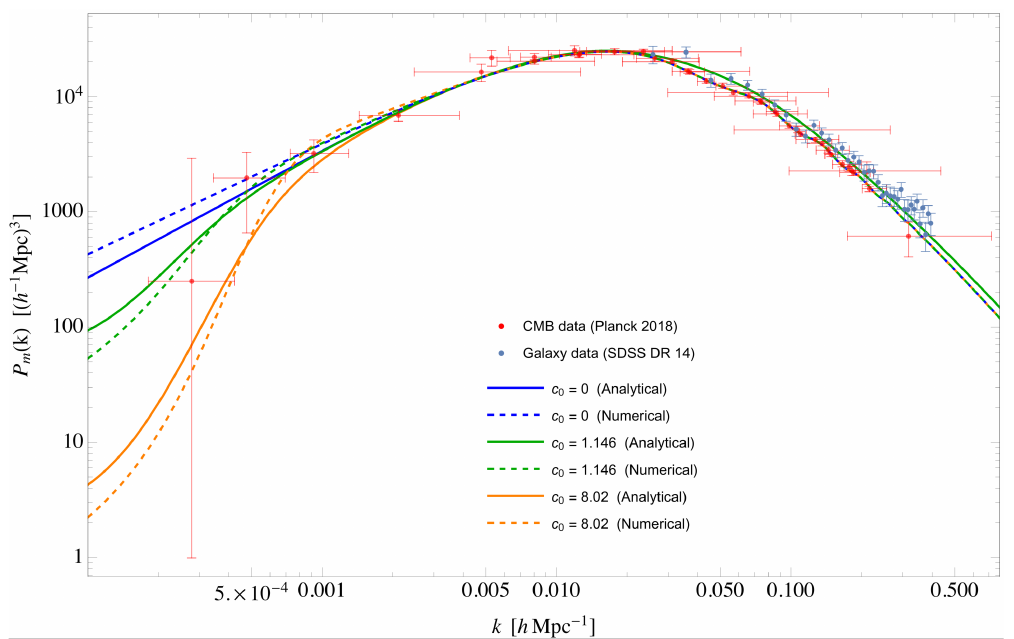
Figure 1. Comparison between the analytical vs. numerical predictions of the RG running of Newton’s constant’s effect on the matter power spectrum P m ( k ) . The solid curves represent the analytical predictions, with the top (blue), middle (green) and bottom (orange) representing the quantum amplitude quantum amplitudes (see Equation (9)) c 0 = 0,1.146,8.02, respectively (see Equation (9)), of which their detailed derivations can be found in [9,10]. The corresponding dashed curves represent the corresponding the numerical predictions generated by ISiTGR, showing very good general consistency with the trend derived from analytical methods. The observational CMB and galaxy data points, taken from the Planck (2018) collaboration [13] and Sloan Digital Sky Survey (SDSS)’s 14th Data Release (DR14) [52] are also